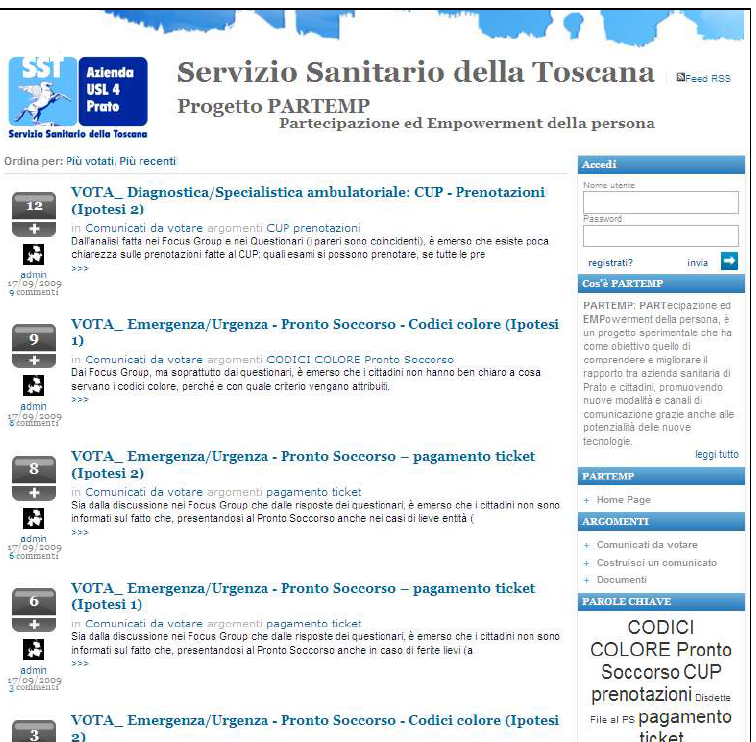
Figure 11: The PARTEMP Project home